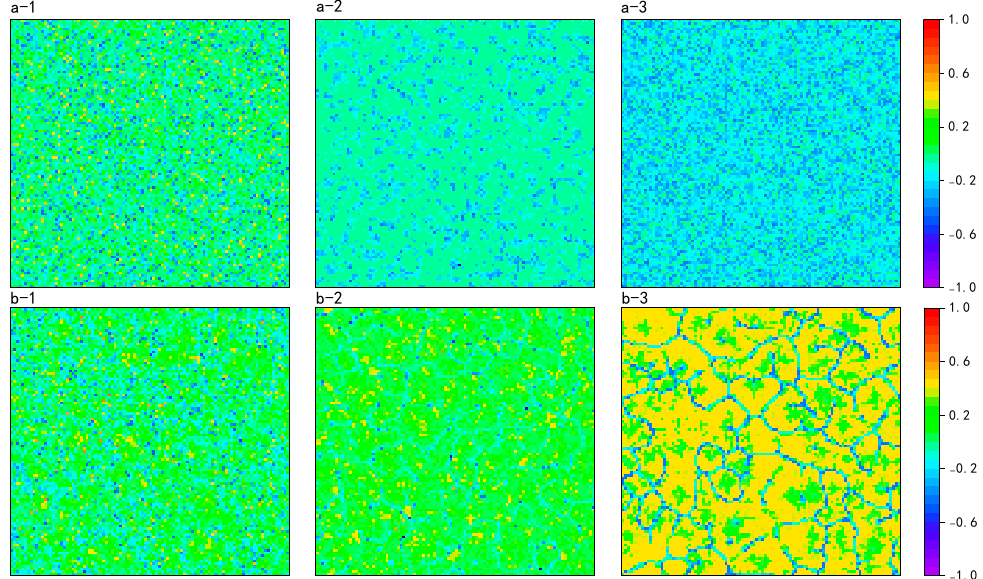
Figure 9. Comparisons of the spatial distribution of the magnitude of strategy change for different combinations of r and α : ( a ) at r = 2.0; ( b ) at r = 4.0. ( 1 ) ω = 0.8, α = infinite; ( 2 ) ω = 0.8, α = 4; ( 3 ) ω = 0.8, α = 1. The color encoding, as depicted at the right of each chart, indicates the values of v i for each individual.